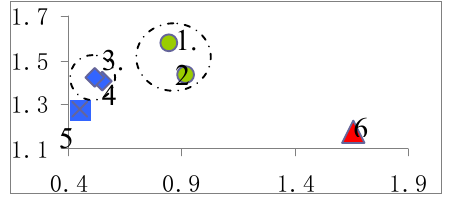
Fig.10. Two-dimension projection